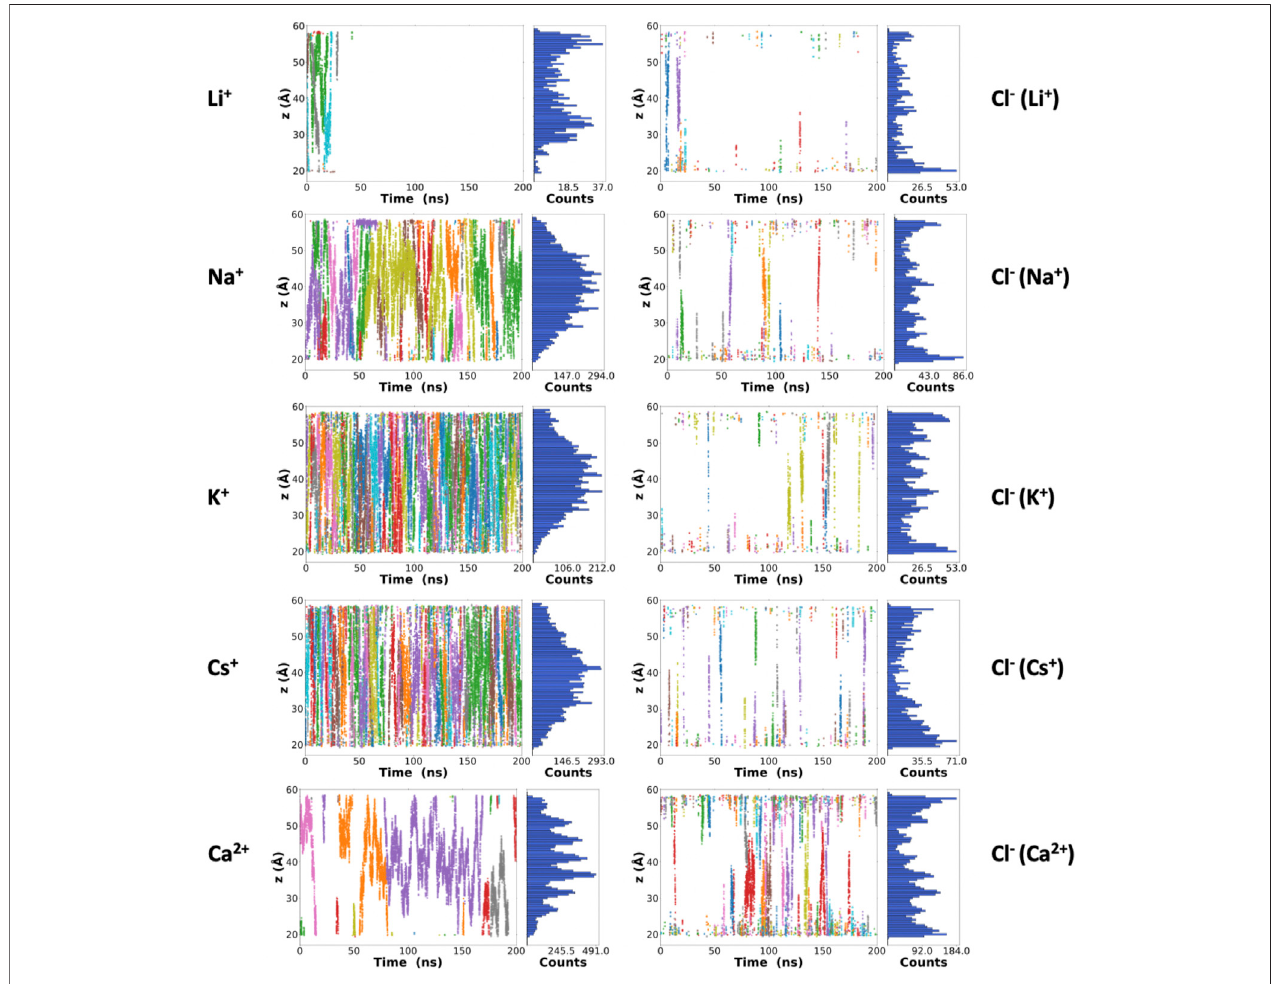
FIGURE 3 | Z-coordinates (along the symmetry axis of the nanotube) for the cations (left) and anions (right) along the 200 ns of the corresponding trajectories. Each color represents a different atom as a function of time. From top to bottom: LiCl, NaCl, KCl, CsCl, and CaCl 2 0.15 M. A complementary plot, with the number of frames where at least one ion is located in each z-position of the nanotube, is also shown at the right side of each graphic.